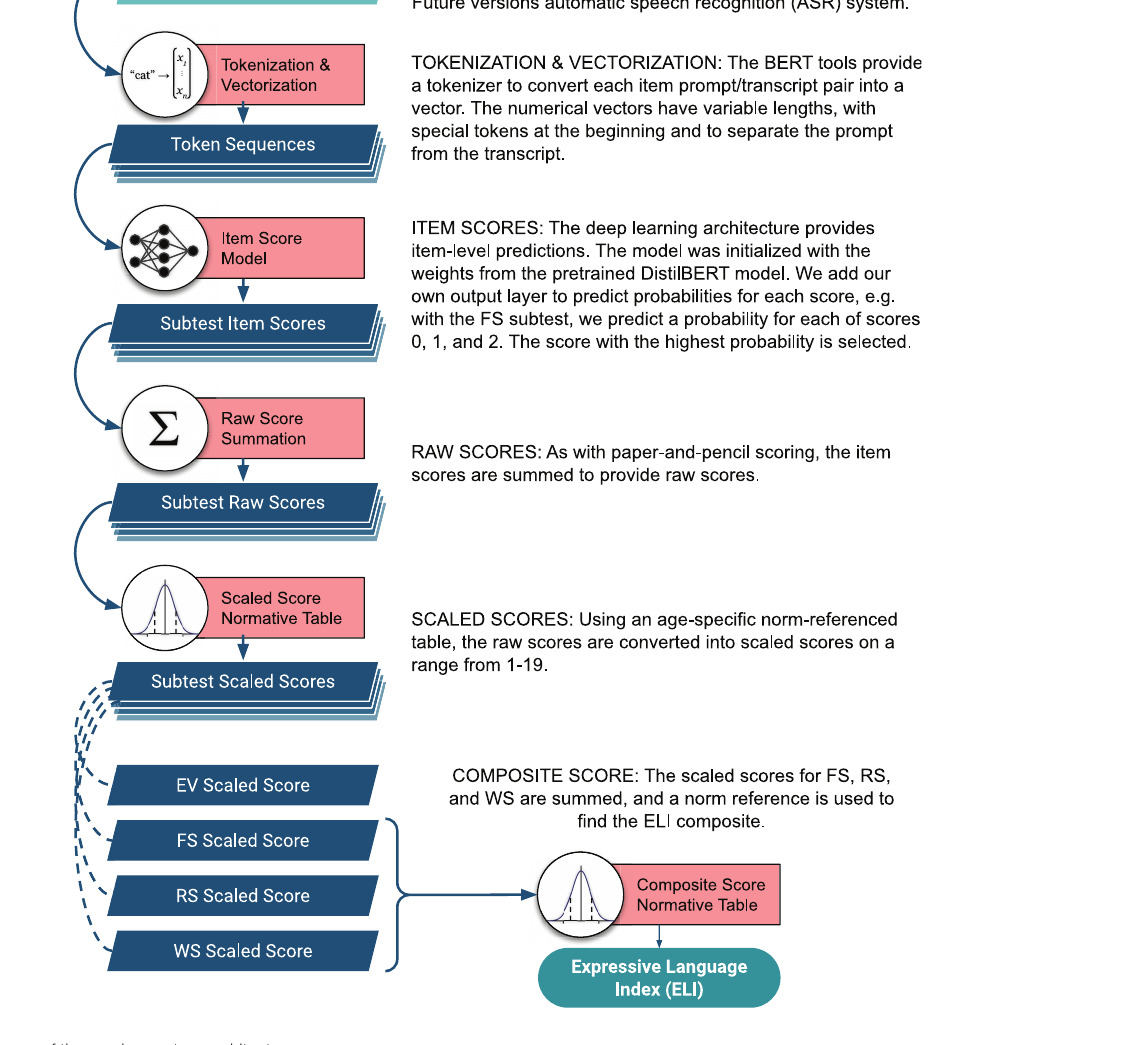
FIGURE 1 | Diagram of the scoring system